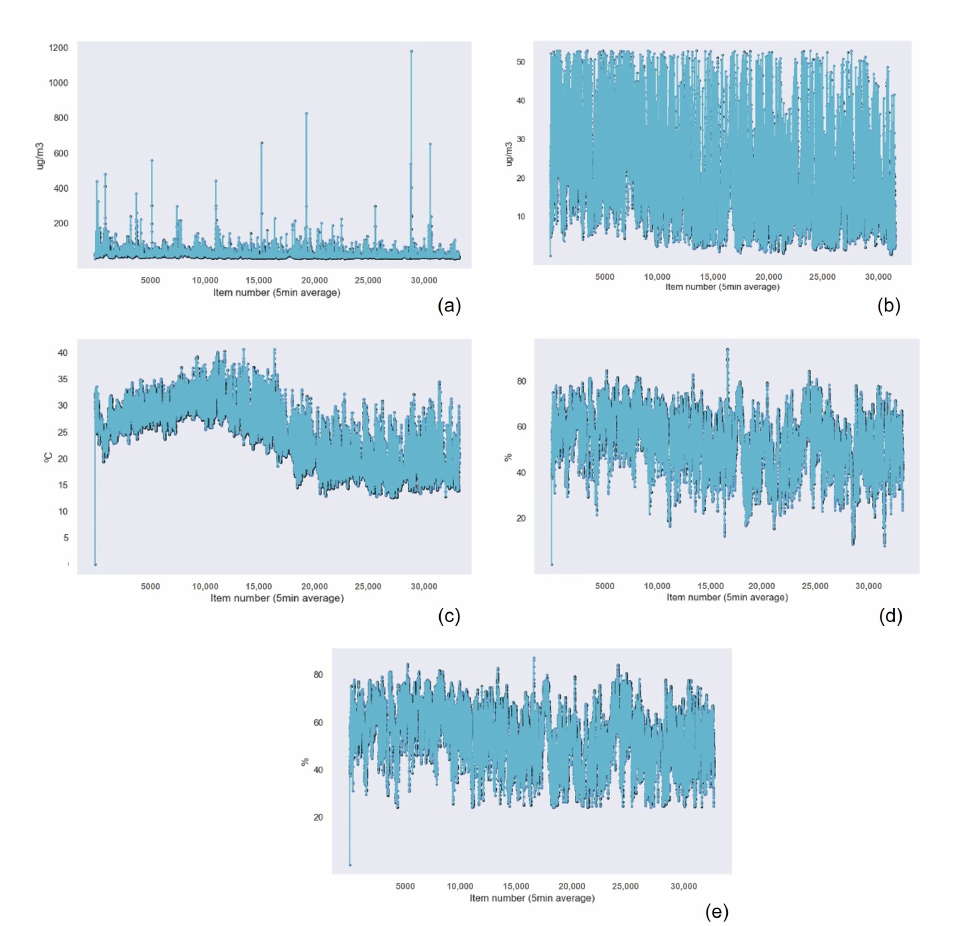
Figure 16. Gaussian Process Regression graphical results for the suspended particulate matter measuring device of ( a ) the PM 10 data with outliers, ( b ) the PM 10 data without outliers, ( c ) the temperature data, ( d ) the humidity data with outliers, and ( e ) the humidity data without